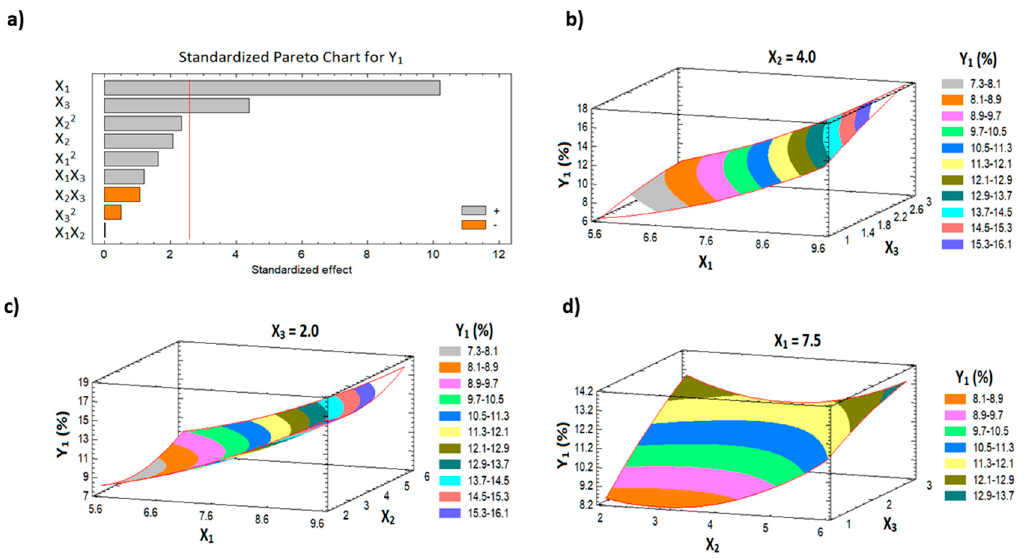
Figure 1. Pareto chart ( a ) and response surface plots ( b – d ) for Y 1 .